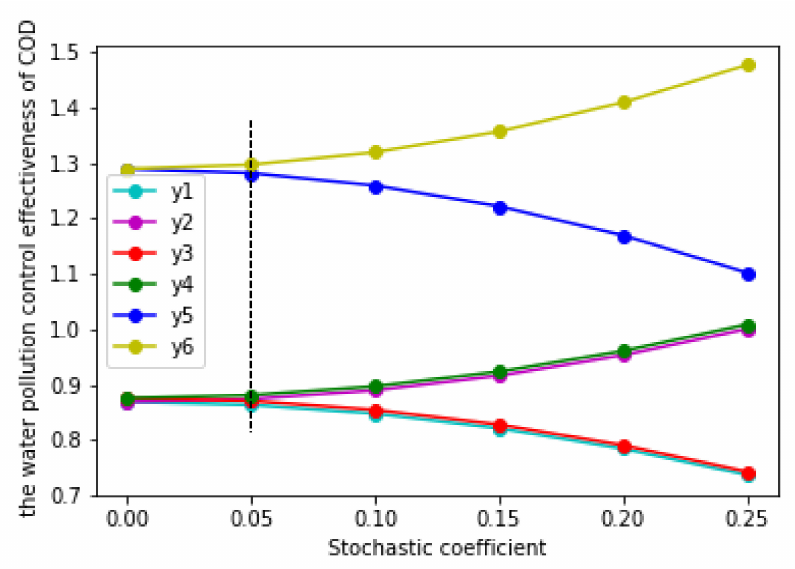
Figure 4. The water pollution control e ff ect measured by in the two